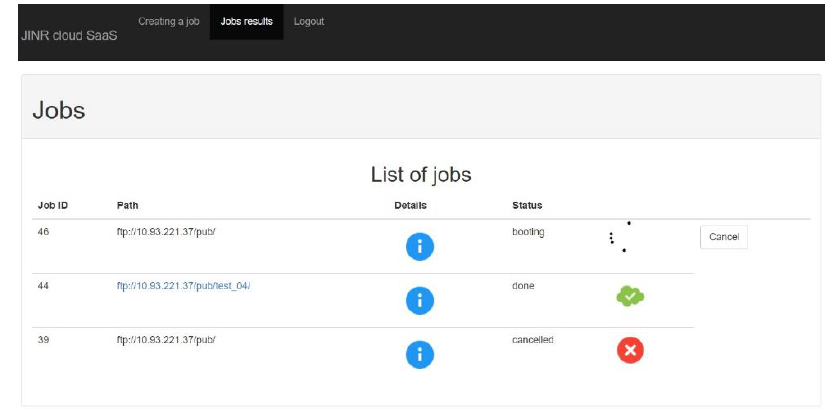
Fig. 5. A screenshot of the “Jobs results” tab with job statuses.